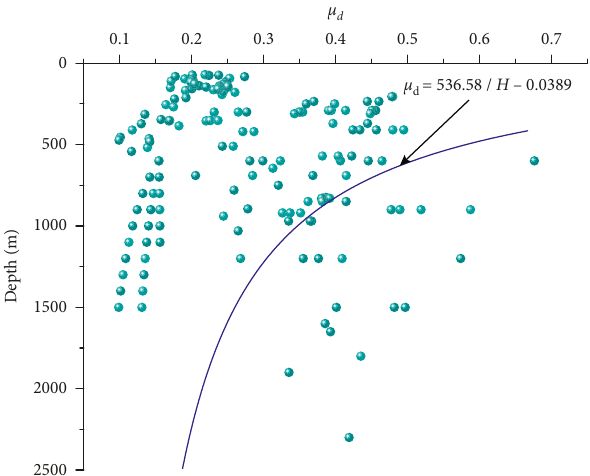
Figure 6: Relative magnitude of horizontal differential stress versus depth distribution and fitting